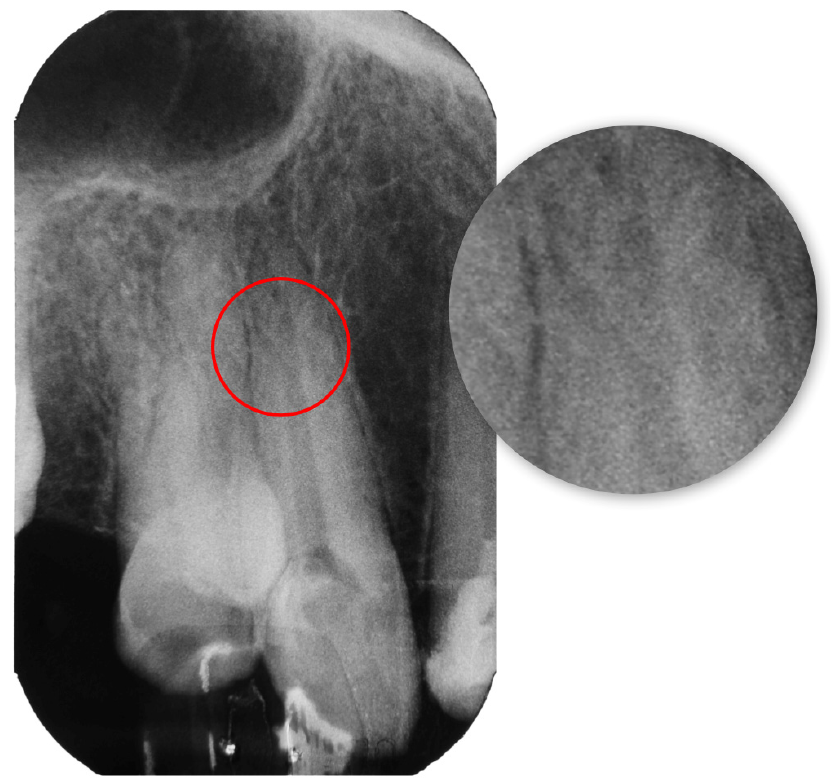
Figure 6. Preoperative x-ray of the right maxillary canine (#13). In the red circle, a distal lateral canal involved in Hypochlorite Accident.